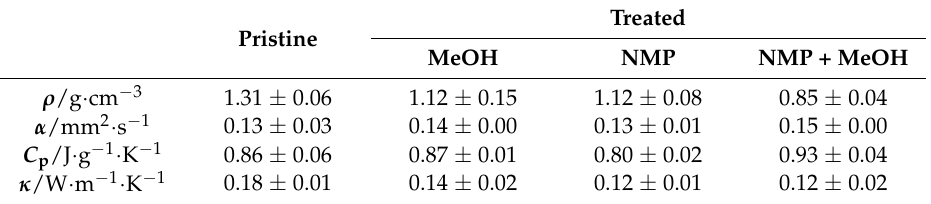
Table 1. Thermal conductivity κ and related data of nano-PETT/PI/SG-CNT hybrid films at 290 K. Pristine